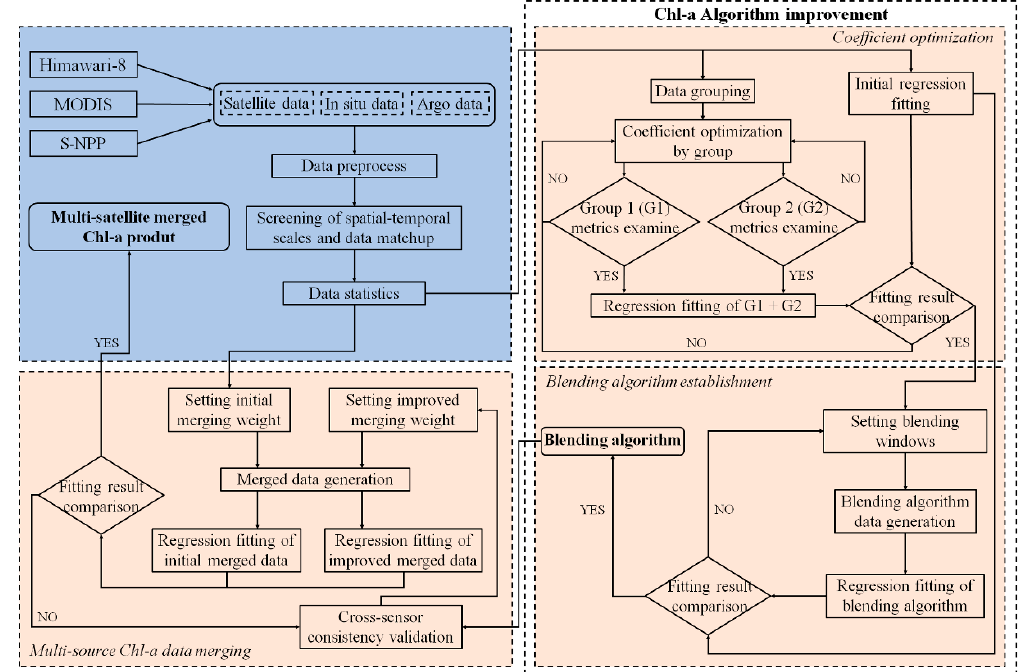
Figure 2. The flowchart of the algorithm